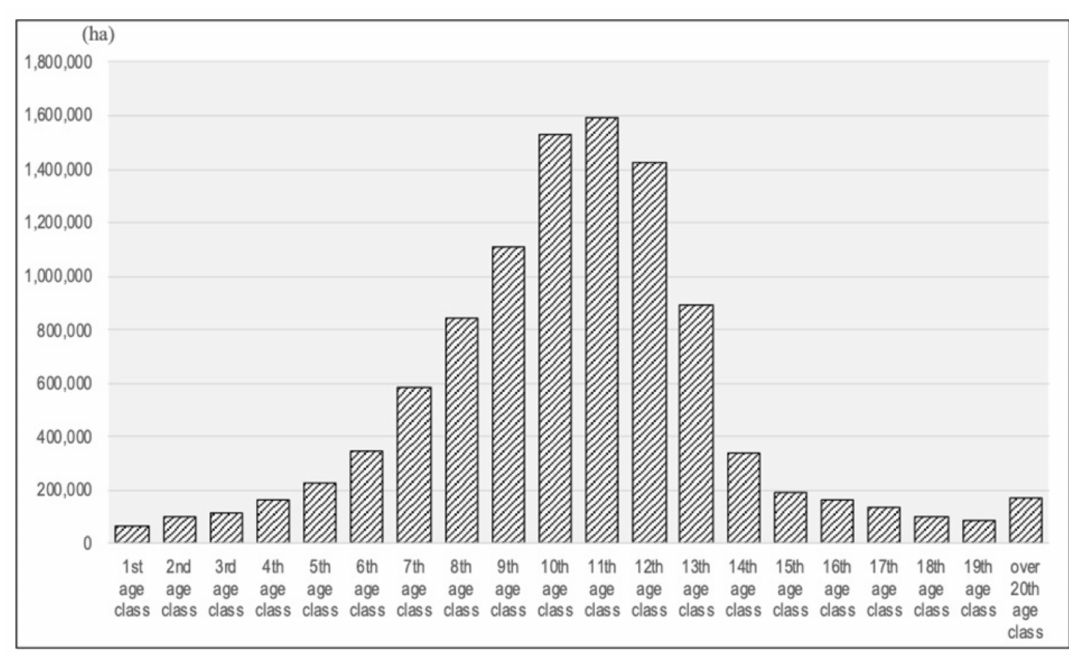
Figure 3. Total area of production forests in Japan presented by age classes in 2017, based on [51].